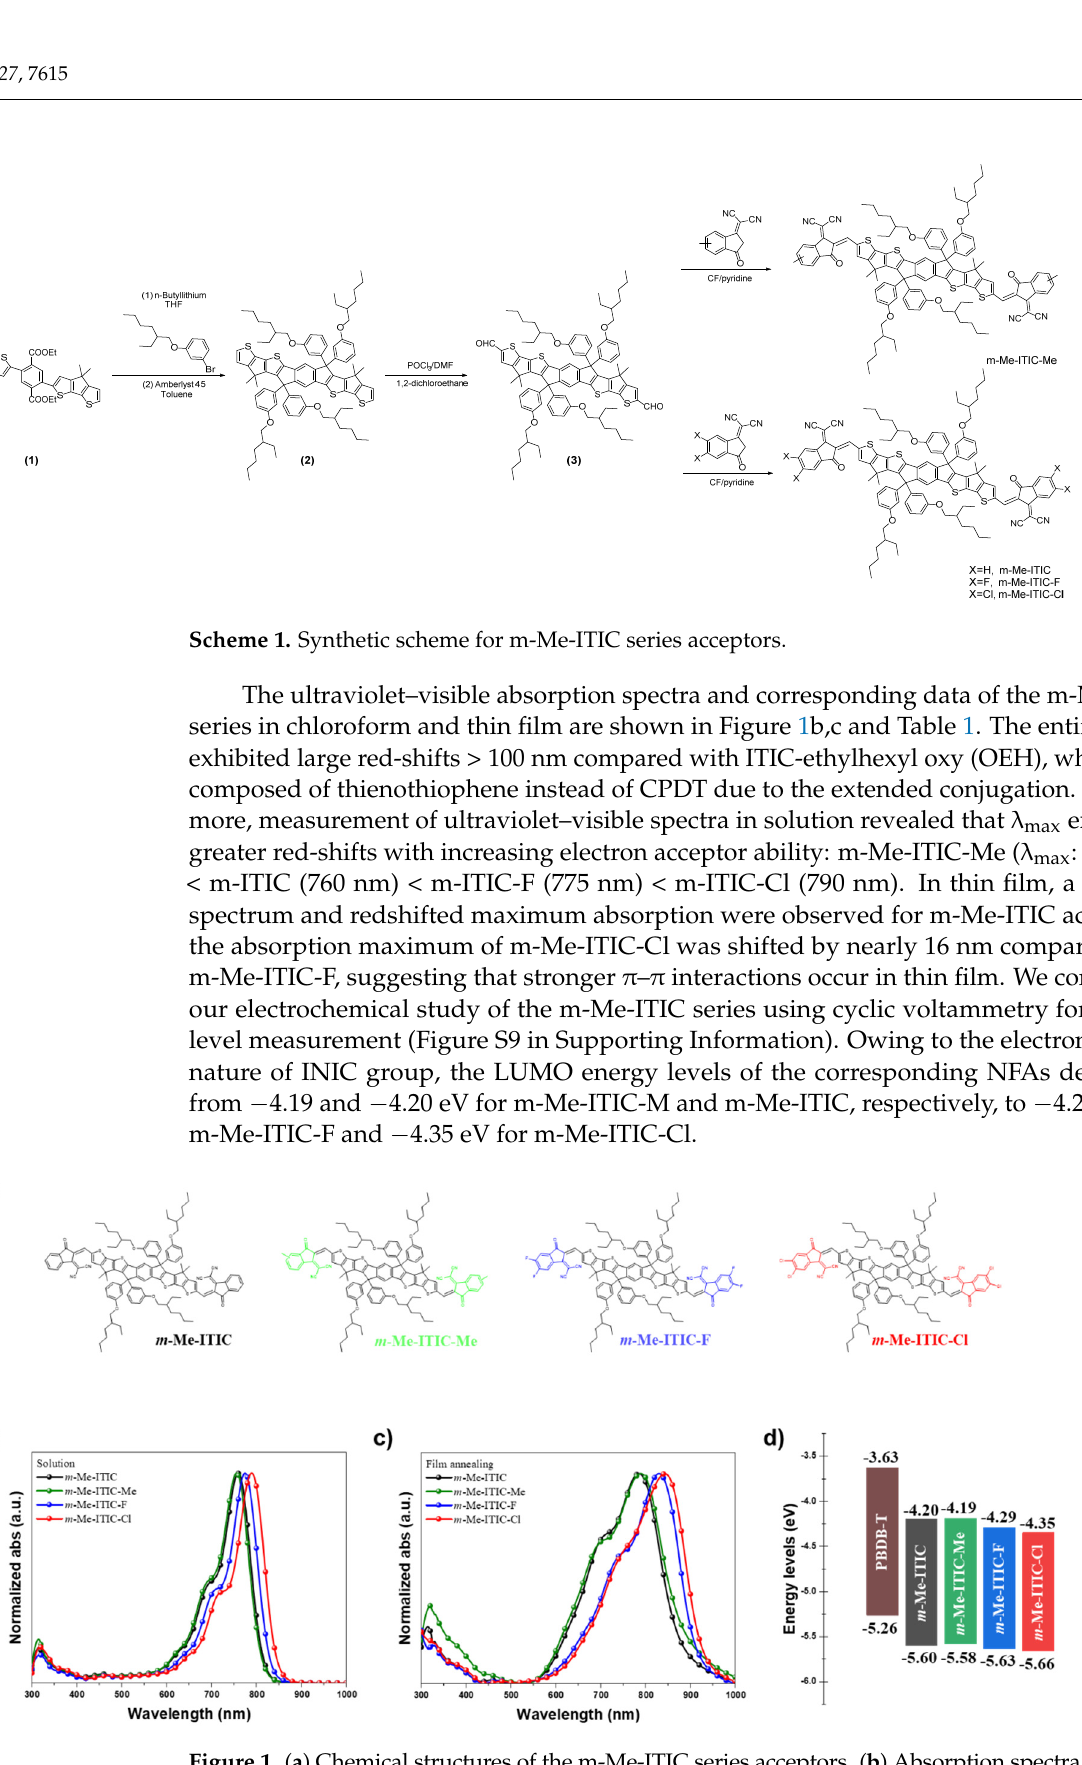
Figure 1. ( a ) Chemical structures of the m-Me-ITIC series acceptors. ( b ) Absorption spectra of